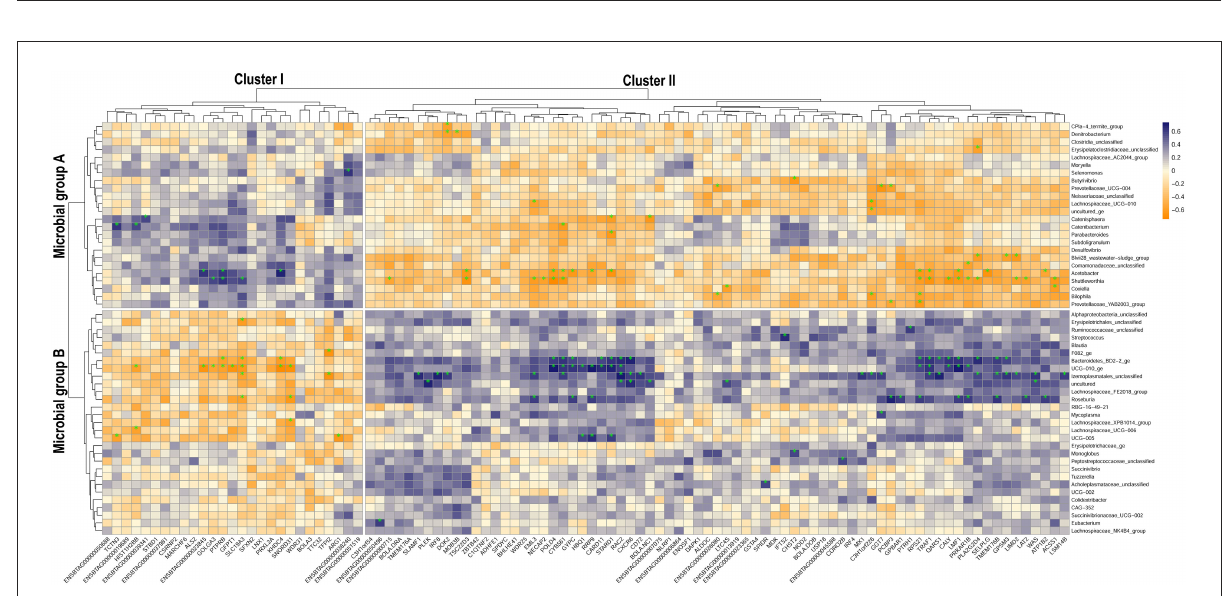
FIGURE3 Correlation map of ruminal host-microbiota interaction depicting the relationship of microbial subset abundances and gene subset transcripts that separate HMUg and LMUg rumen profiles. Subsets derived from sPLS-DA analysis; estimated correlations are based on the microbial abundances and gene transcripts in HMUg and LMUg cows; *indicates significant correlation ( p < 0.01).